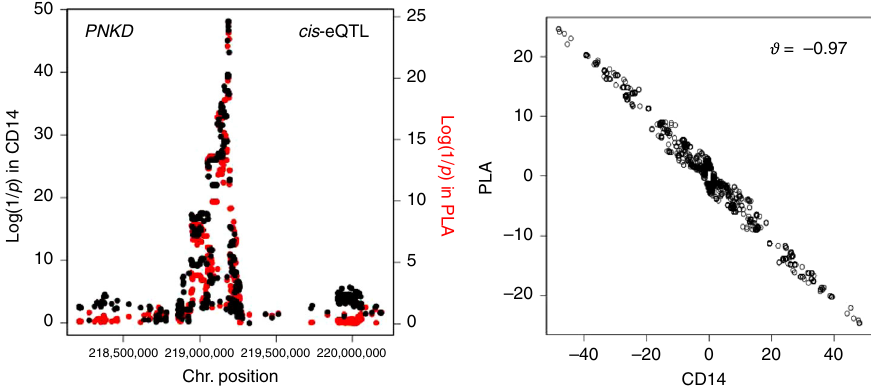
Fig. 4 Variant(s) with opposite effects on expression in two cell types. Example of a gene ( PNKD ) affected by a cis -eQTL in at least two cell types (CD14 and platelets) that are characterized by EAP with ϑ = − 0.97, indicating that the gene ’ s expression level is affected by the same regulatory variant in these two cell types, yet with opposite effects, i.e., the variant that is increasing expression in platelets is decreasing expression in CD14